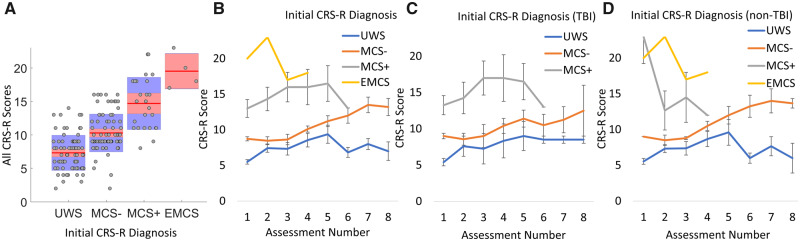

Initial diagnosis as a predictor of recovery. (A) Boxplot of all 185 CRS-R scores collected from all patients, grouped by initial diagnosis. Pairwise Bonferroni contrasts showed no difference between MCS patients but statistical differences between UWS and both the MCS− and MCS+ groups. (B) Mean CRS-R scores for patients grouped by initial diagnosis at each assessment. (C) Mean CRS-R scores at each assessment for patients with a TBI aetiology grouped by initial diagnosis. (D) Mean CRS-R scores at each assessment for patients with a non-TBI aetiology grouped by initial diagnosis. Standard error bars represent the standard errors of the means for all plots.